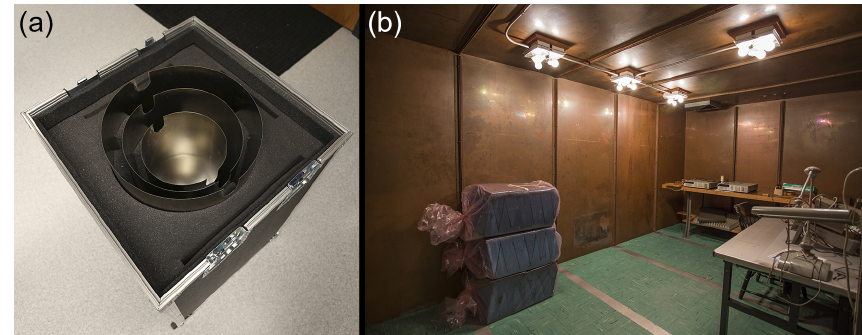
Figure 4. Three-layer shield can (a) and copper room (b) used for the characterization for the PNI RM3100